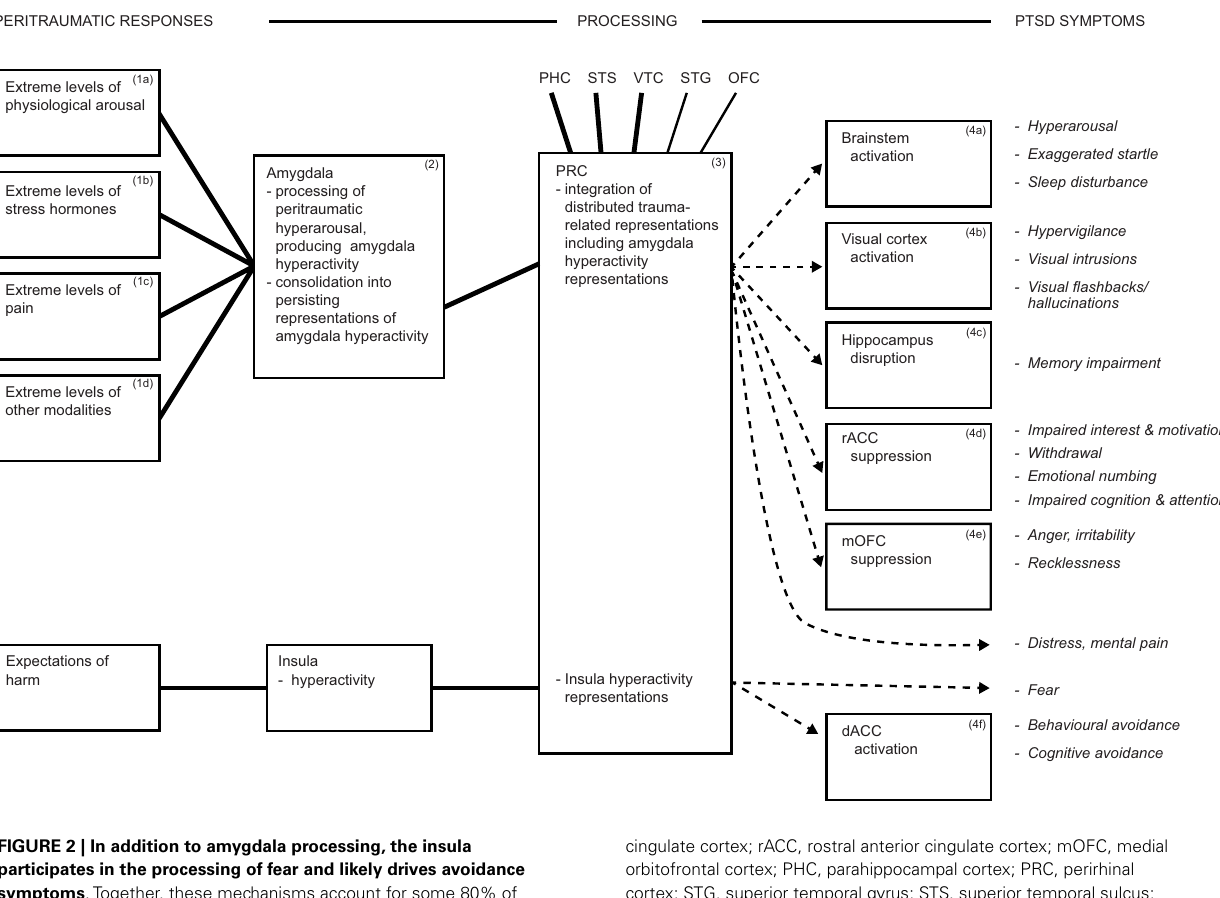
cingulate cortex; rACC, rostral anterior cingulate cortex; mOFC, medial orbitofrontal cortex; PHC, parahippocampal cortex; PRC, perirhinal cortex; STG, superior temporal gyrus; STS, superior temporal sulcus; VTC, ventral temporal